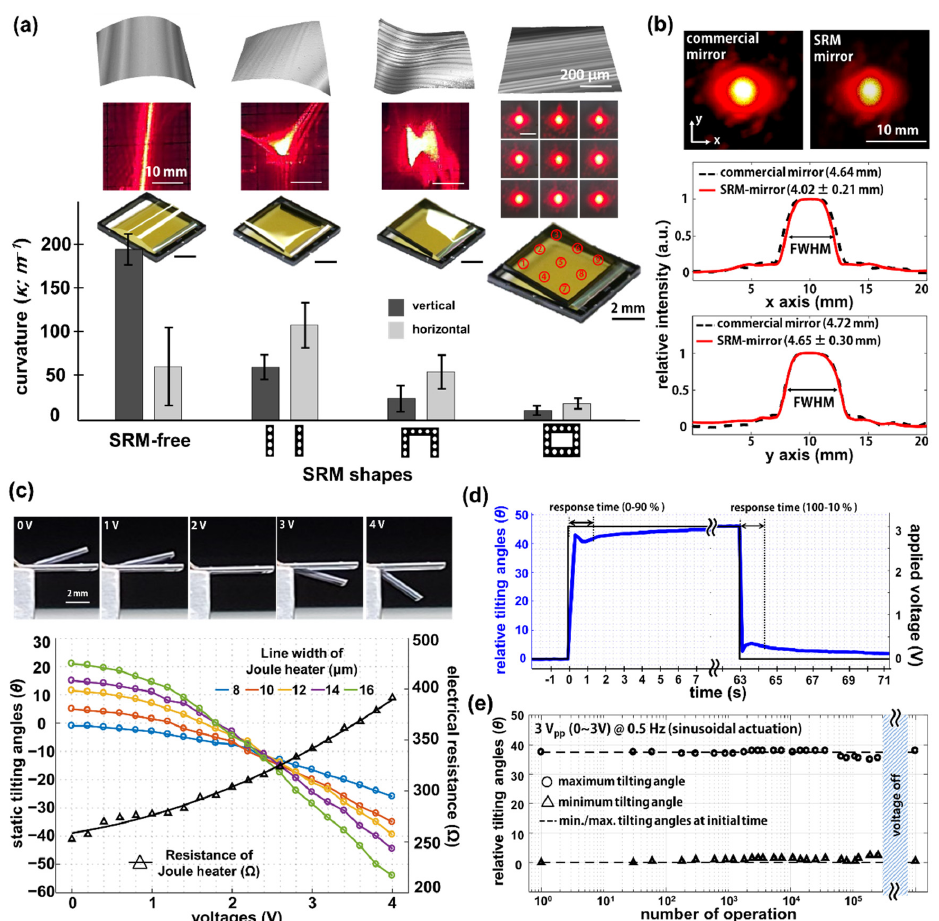
Figure 4. Mechanical and optical characterization of the SRM-mirror. ( a ) Measured film curvatures of the SRM-mirror depending on the shape of silicon rims. Insets correspond to 3D-reconstructed images of membrane (top row), images of reflected laser spots (middle row), and optical images (bottom row). ( b ) Beam profile analysis of reflected laser beam spots from a commercial mirror and SRM-mirror. ( c ) Measured tilting angles of the SRM-mirror and resistances of the Al Joule heater during electrothermal actuation with varied voltages from 0 V DC to 4 V DC . Insets are side-view images of the SRM-mirror during actuation. ( d ) Step response of the SRM-mirror with static actuation between the voltages of 0 V DC and 3 V DC . ( e ) Fatigue test of the SRM-mirror. The sinusoidal waveform with 0.5 Hz/3 V pp (0–3 V) was applied for three days. The minimum and maximum tilting angles were measured at the specified time.